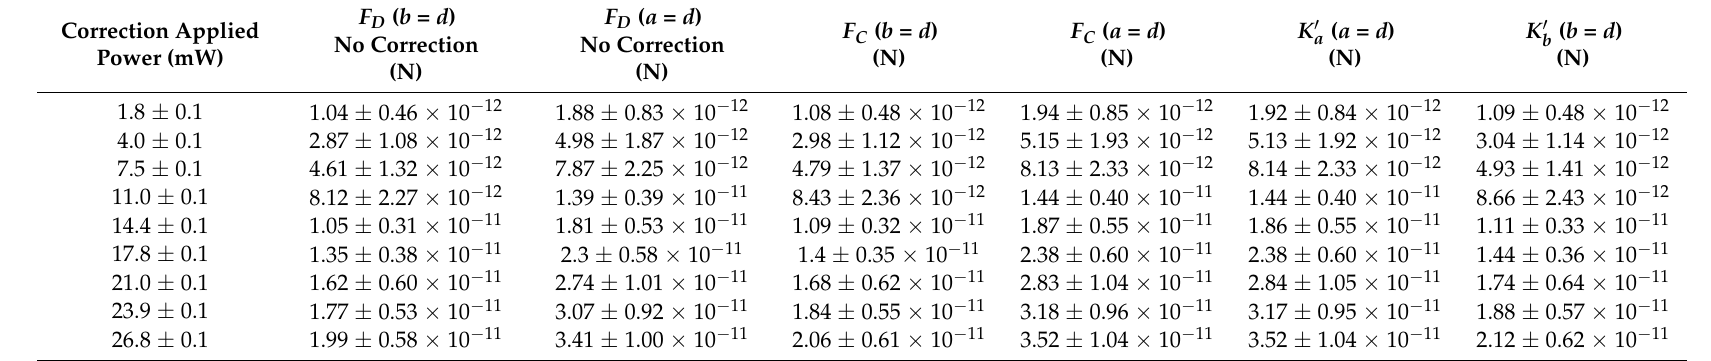
Table 1. Stokes’ Drag Forces with no correction applied ( F D ) (Equation (1)) and with Faxen’s correction ( F c ) (Equation (2)) and ellipsoidal shape correction ( K (cid:48) a (Equation (3)) and K (cid:48) (Equation (4)) applied. a = minor axis (cell width), b = major axis (cell length) and d = particle b